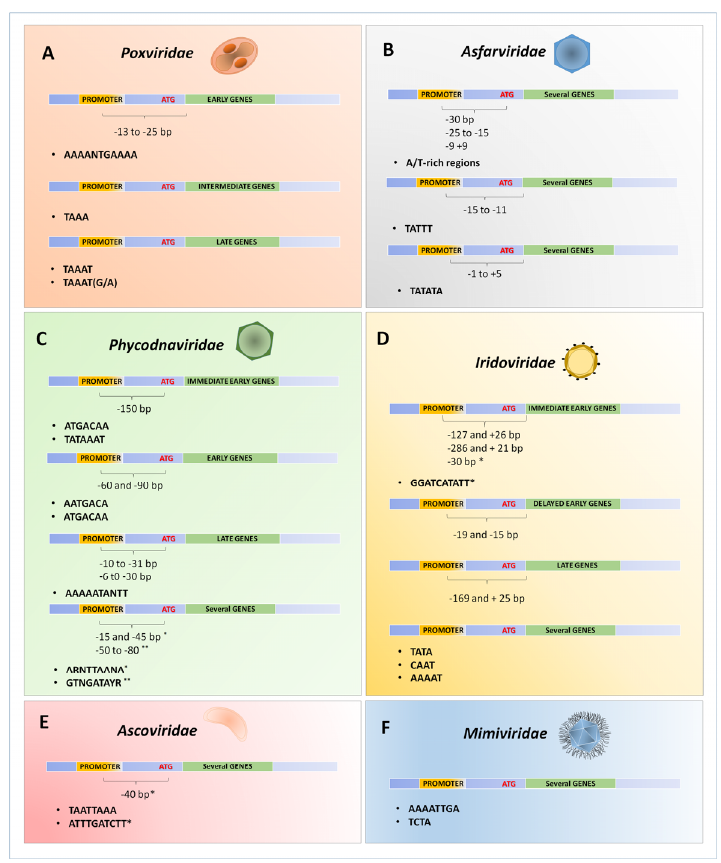
Figure 3. Schematic representation of the promoter’s sequences described for different NCLDVs. Compilation of the described promoters for some viral families belonging to the proposed order Megavirales: Poxviridae ( A ); Asfarviridae ( B ); Phycodnaviridae ( C ); Iridoviridae ( D ); Ascoviridae ( E ) and Mimiviridae ( F ). Each promoter was related to the expression of immediate early, early, delayed early, intermediate and late genes, or related to the expression of genes independent of temporal expression (several genes). The distances between the transcription start site or translate start site (ATG) until the promoters are also indicated by